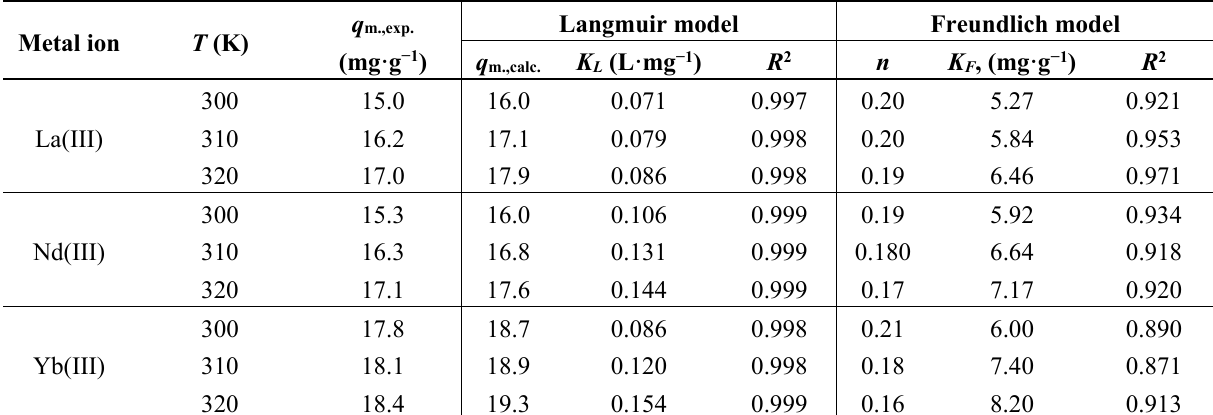
Figure 8. Adsorption isotherms for La(III), Nd(III) and Yb(III) ions at different temperatures. ( t = 4 h; T = 300 K; pH = 5; m = 0.05 g; V = 20 mL). Table 3. Parameters of the Langmuir and Freundlich equations for the sorption of La(III), Nd(III) and Yb(III) metal ions using cysteine-based magnetic-chitosan nanoparticles at different